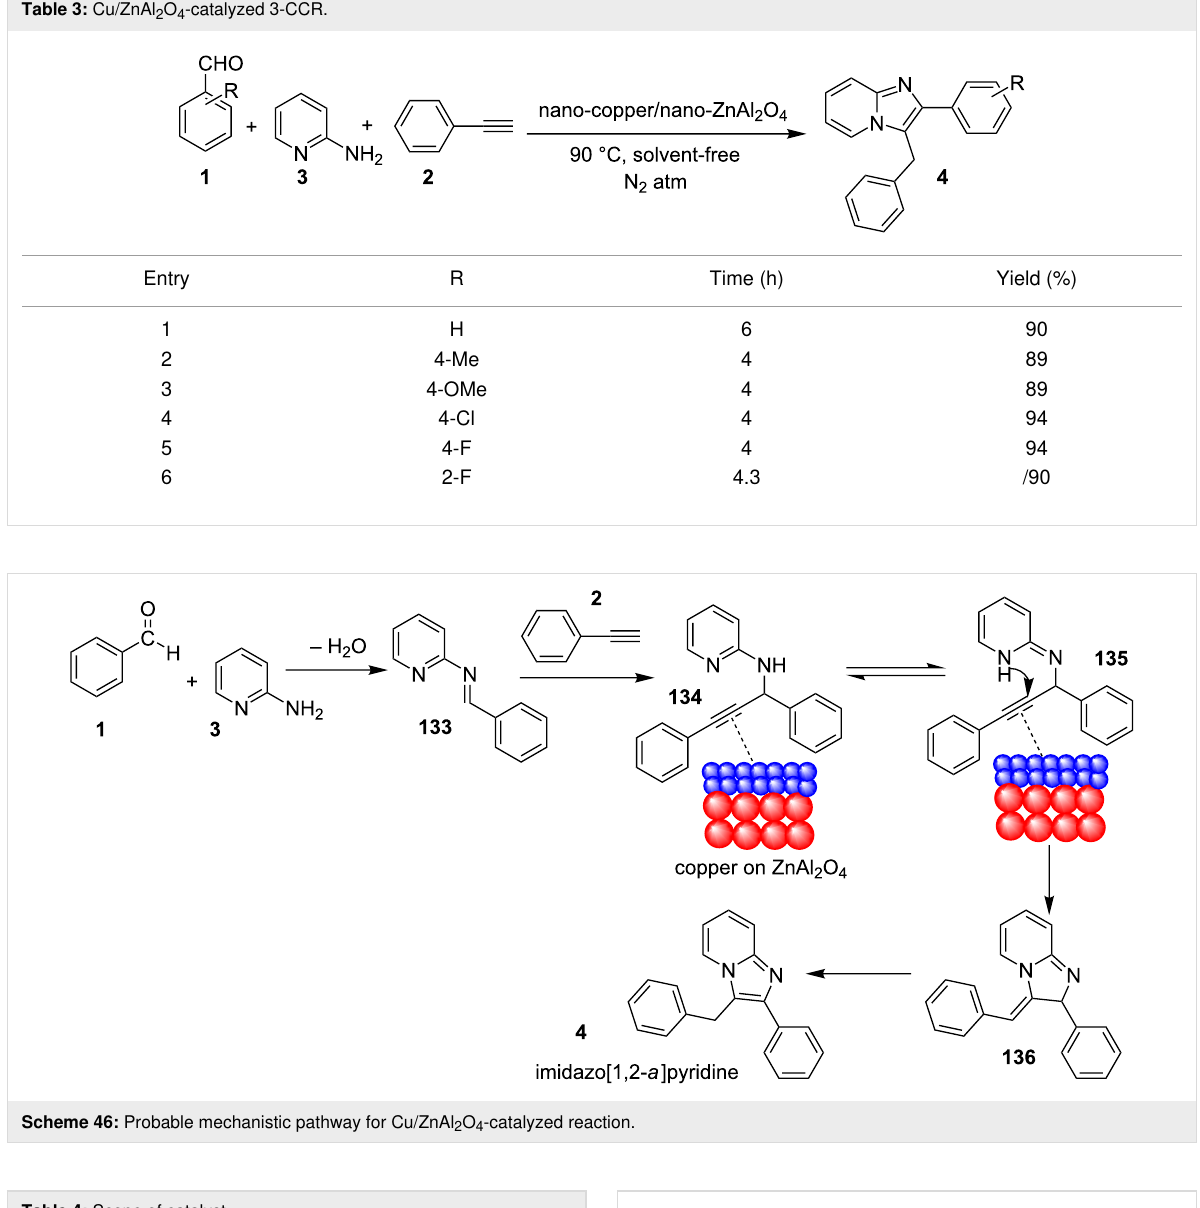
Table 3: Cu/ZnAl 2 O 4 -catalyzed 3-CCR.